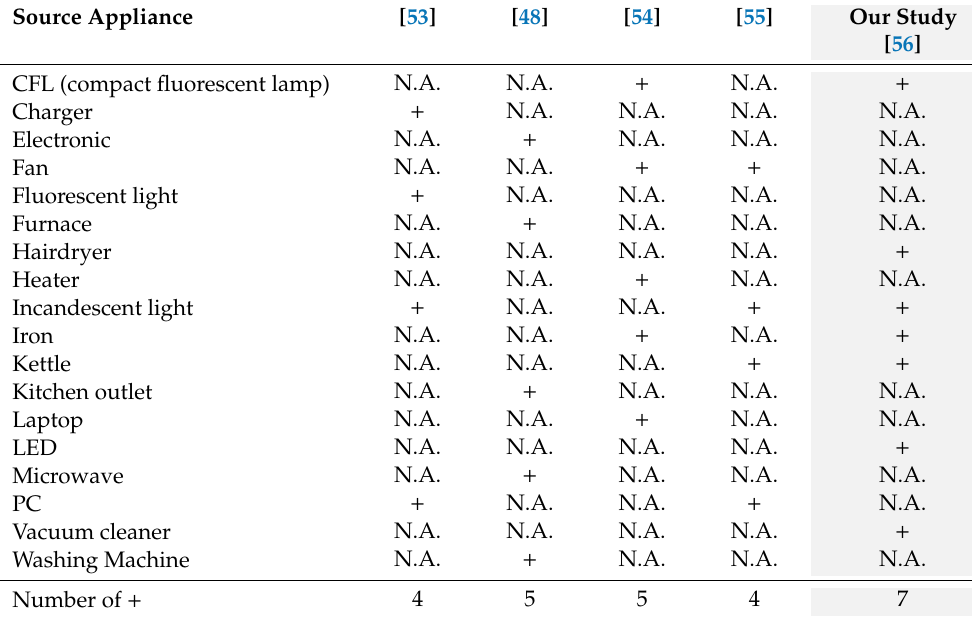
Table 3. Groups of appliances possible to classify properly using selected medium-frequency (MF)